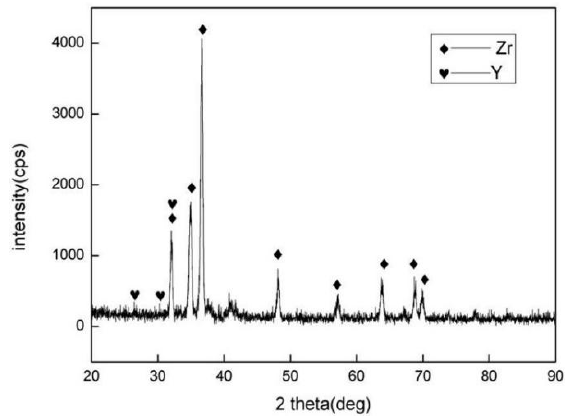
Figure 4. XRD pattern of the Zr-Y coating.